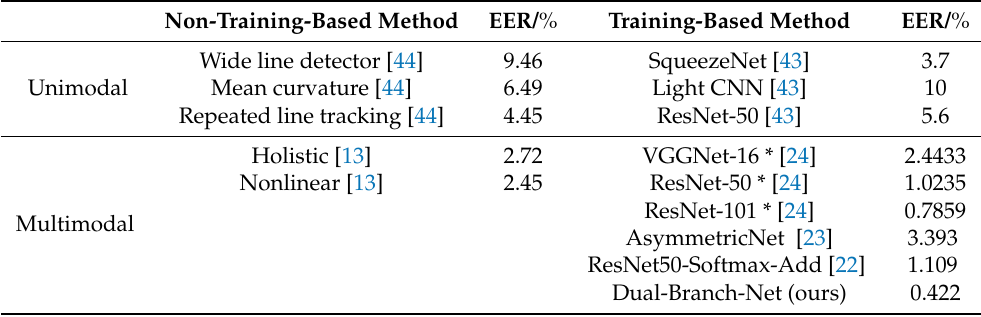
Table 2. Results of comparative experiments. Non-training-based represents traditional methods without training, and training-based represents methods based on CNNs. The unimodal methods use only FV, while the multimodal methods use FV and IKP (methods with * use FV and hand shape). Non-Training-Based Method EER/ % Training-Based